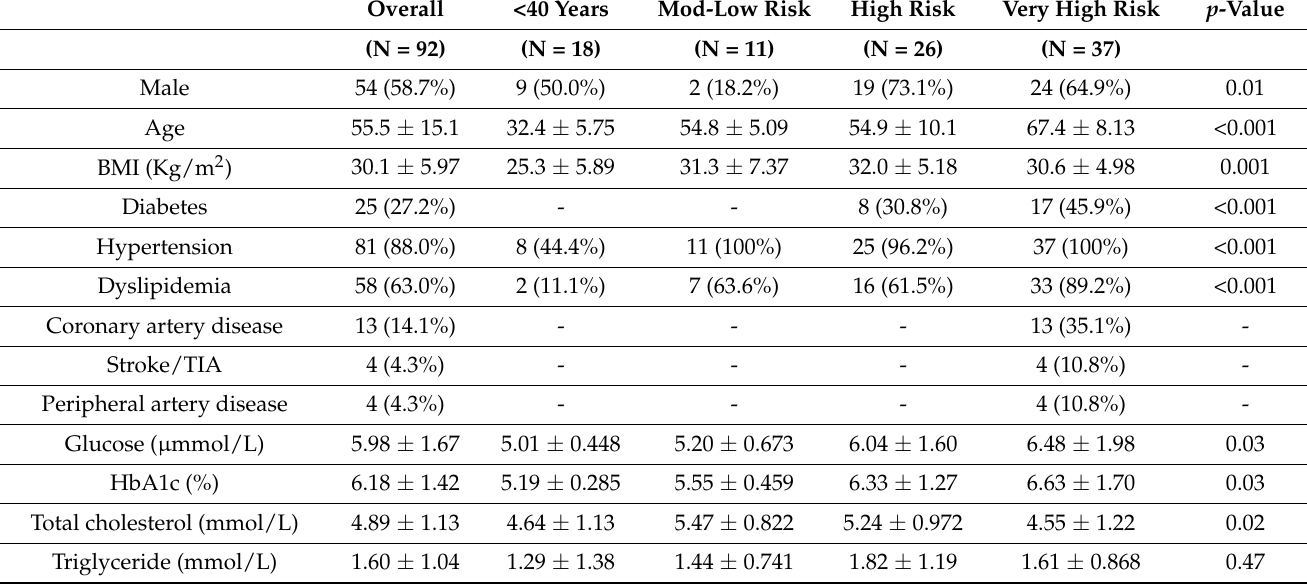
Table 1. Baseline characteristics stratified by risk